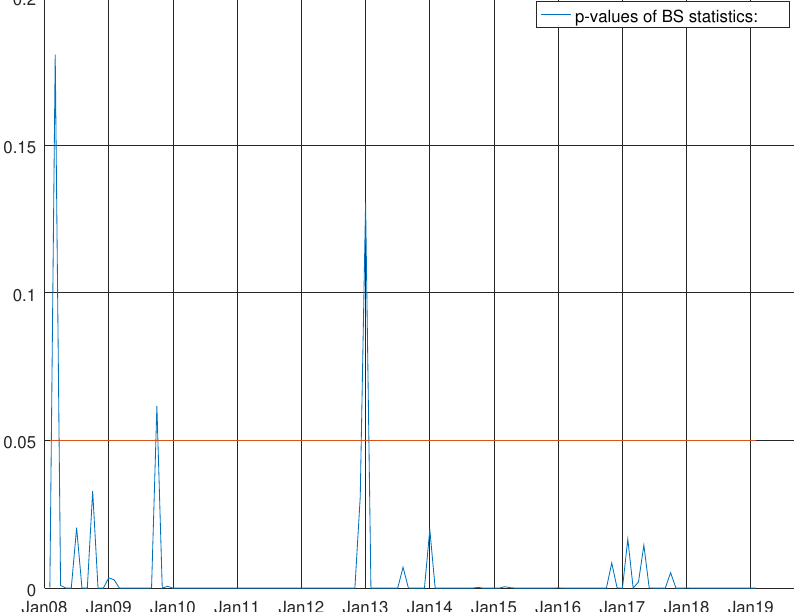
Figure 10. Graph showing the p -values of the Bowman–Shenton test for the VARMA model using both hard and soft data for non-durable goods. The null hypothesis states that errors are normally